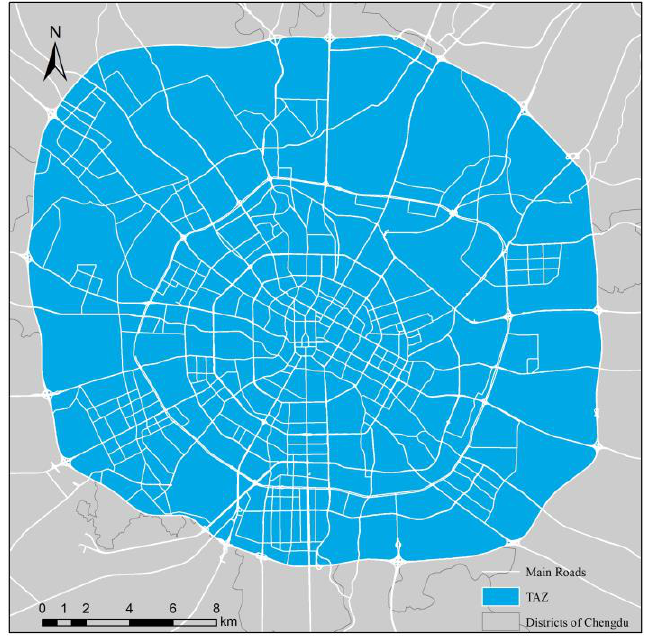
Figure 2. Traffic analysis zones. Traffic analysis zones were obtained by cutting study area with Figure 2. Tra ffi c analysis zones. Tra ffi c analysis zones were obtained by cutting study area with main main roads network, and they were taken as the basic spatial unit in this study. roads network, and they were taken as the basic spatial unit in this Vehicle trajectory data were acquired from the GAIA open data initiative (https://gaia.didichuxing.com) of Didi Chuxing. Didi Chuxing, which is a travel platform for taxi,